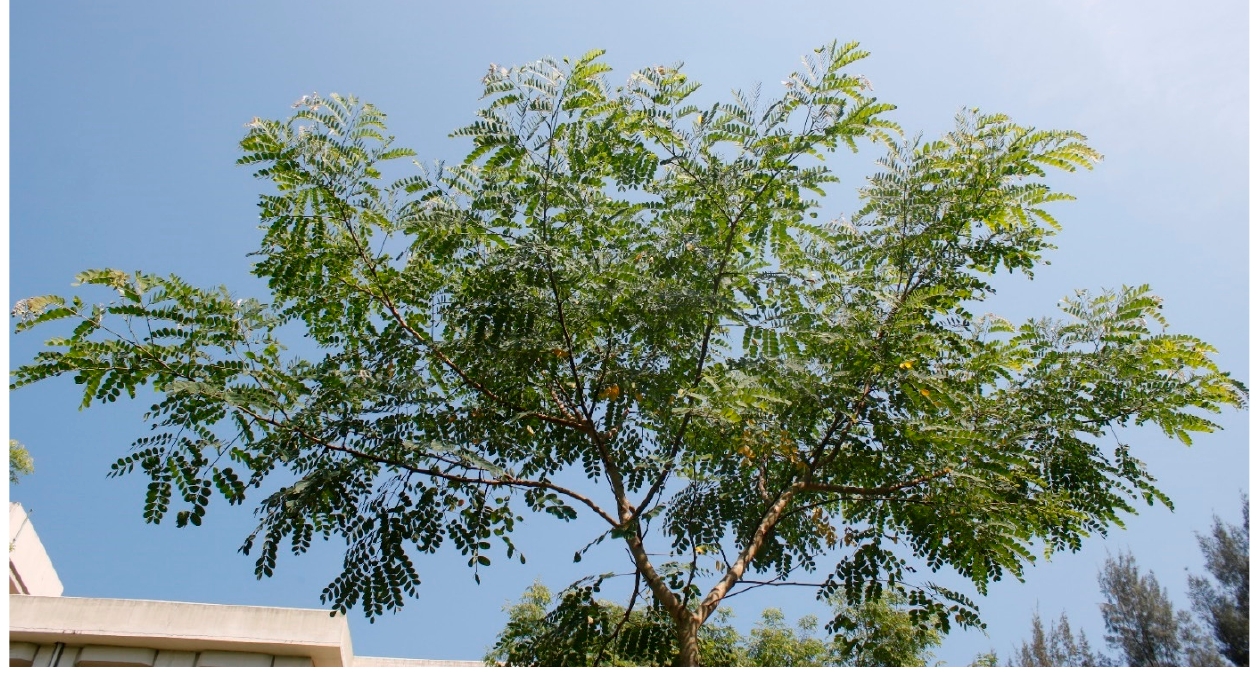
Figure 1. Albizia procera (Roxb.) Benth. tree